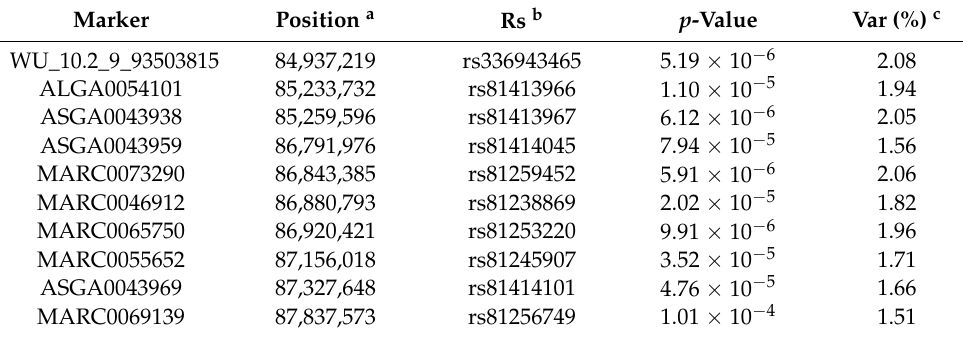
Figure 1. GWAS for LMA. ( A ) Manhattan plots for LMA. The red horizontal line indicates the FDR threshold (1.04 × 10 − 4 ). ( B ) Quantile–quantile plot of SNPs after quality control in genome-wide association analysis for LMA. Table 1. Description of SNPs significantly associated with LMA on